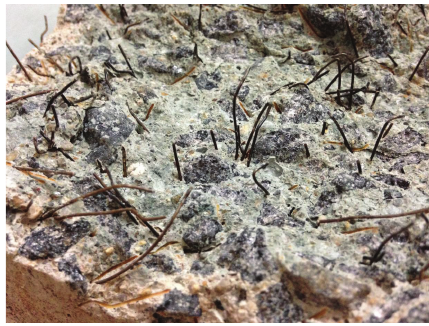
Figure 12: Fractured surface of geopolymer concrete showing fibre